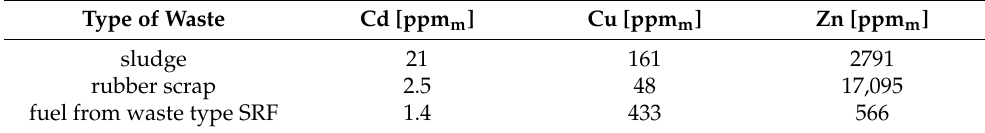
Table 3. Concentrations of metals in waste.